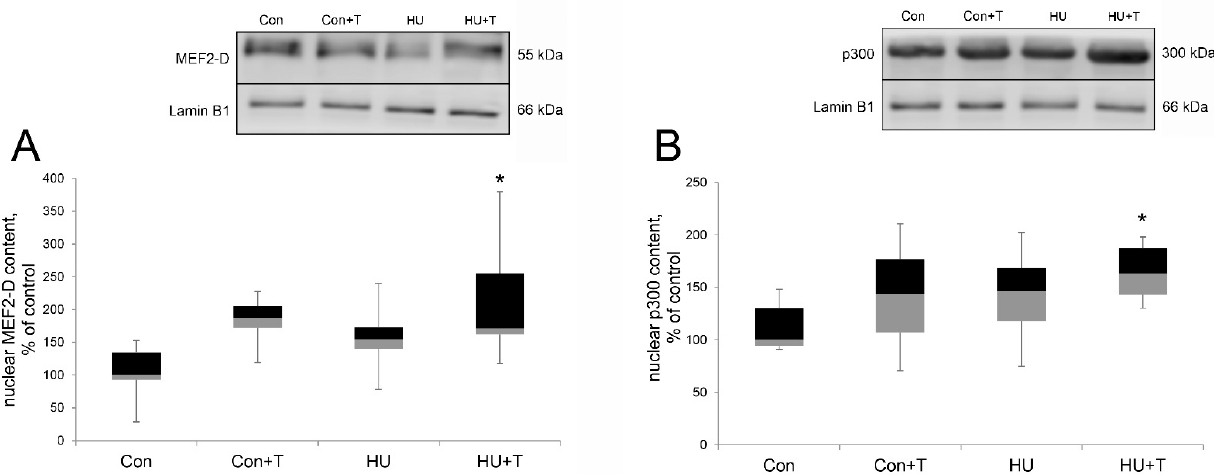
Figure 4. Western blot analysis of MEF2-D ( A ) and p300 ( B ) nuclear content in rat soleus muscle in control group (Con), control group with Tasquinimod treatment (Con + T), 24 h of hindlimb unloading via hindlimb suspension (HU), 24 h of hindlimb unloading via hindlimb suspension with Tasquinimod treatment (HU + T). Data are shown as % of the control group. *—significant difference from the control group ( p < 0.05). Box plots show 25–75 percentiles and median values and the whiskers represent the minimum and the maximum; n = 8/group.